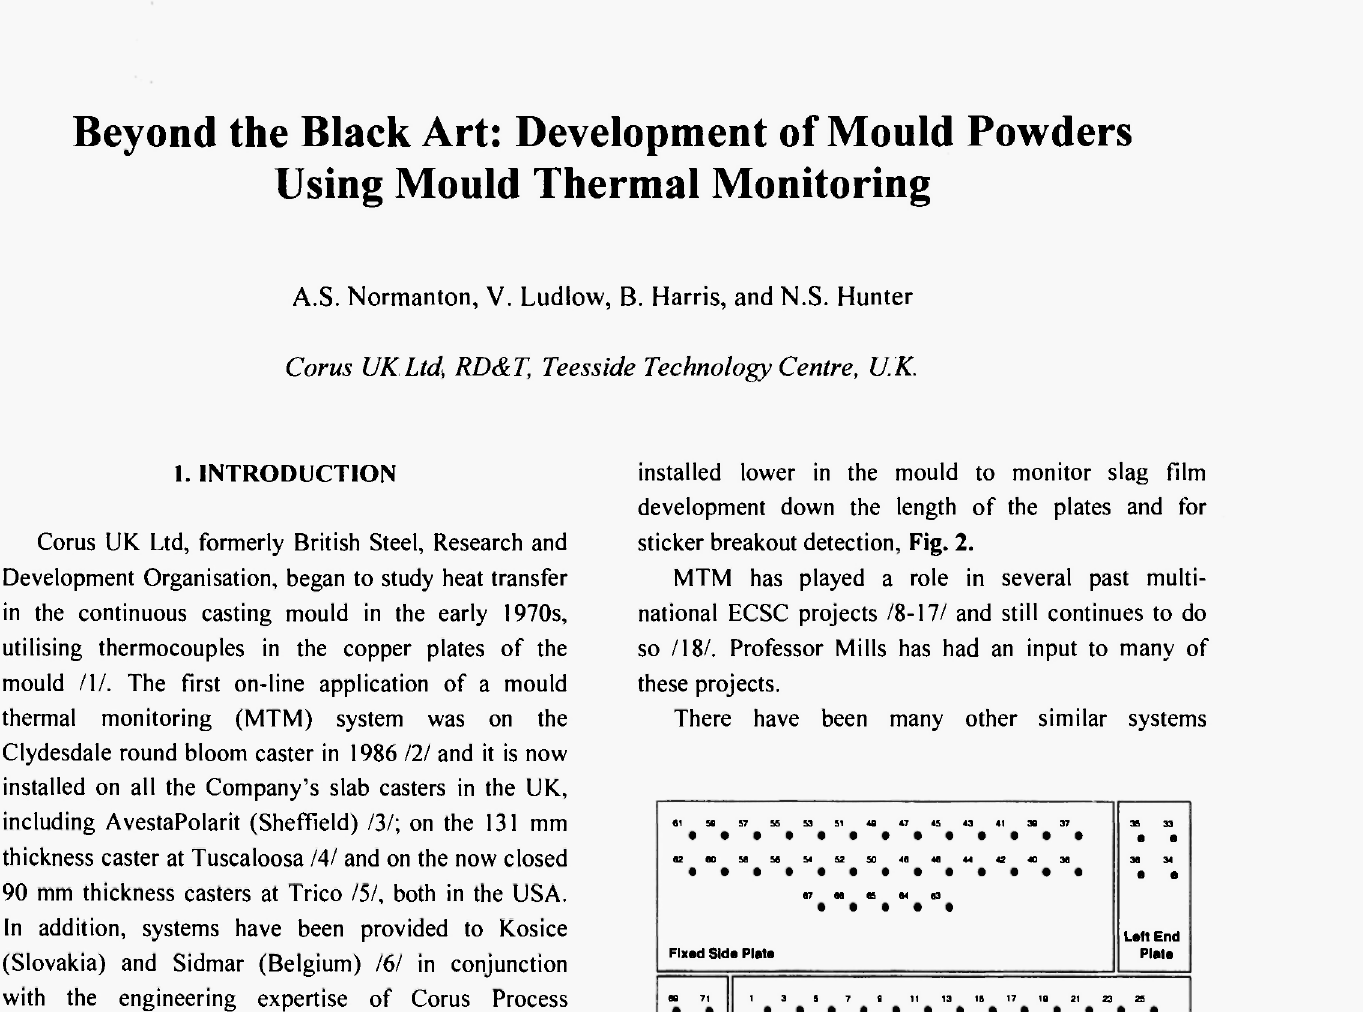
Fig. 1: Trico instrumented mould.